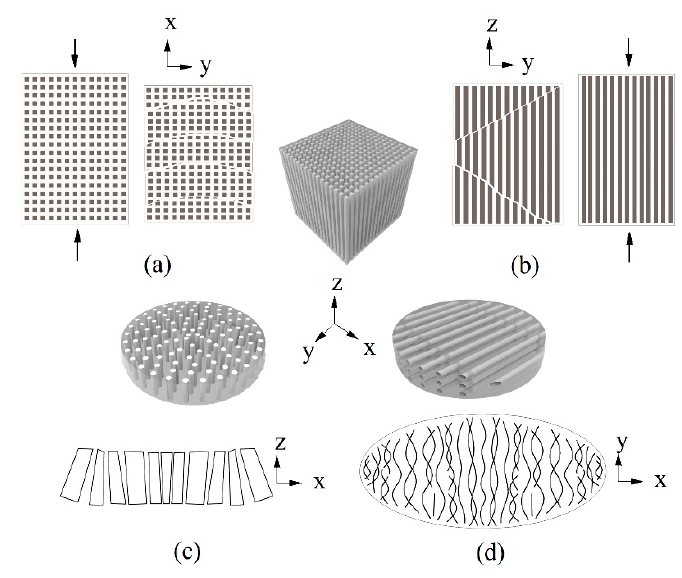
Figure 14. The diagram of failure modes of beech specimens under static and dynamic tests: ( a ) QTRD,